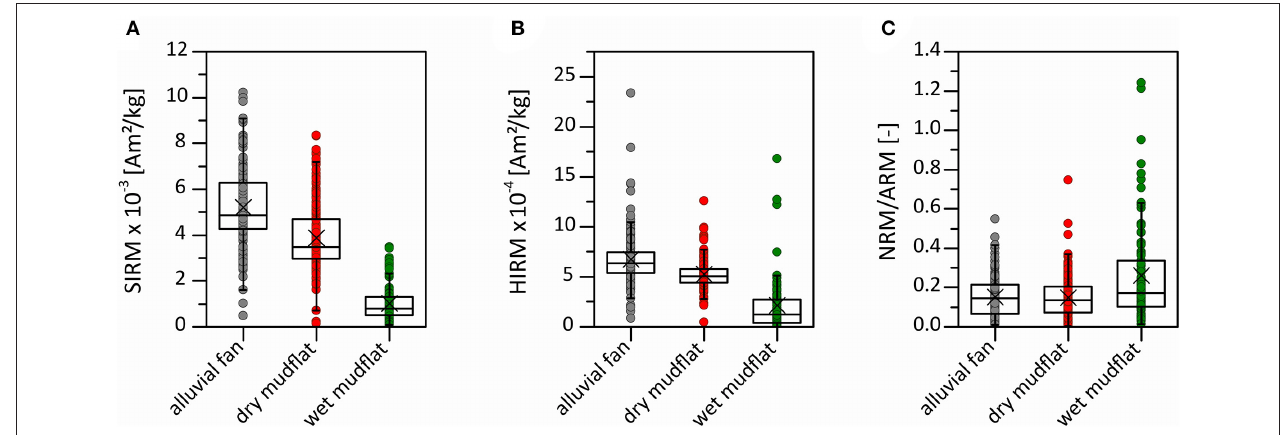
FIGURE 9 | Lithofacies and rock magnetic characteristics: box plots of the concentration-dependent parameters (A) SIRM, (B) HIRM, and (C) NRM/ARM ratio with means indicated by crosses, quartiles boxes and whiskers with a factor of 1.5. All consistently indicate statistically different mean values for the wet mudflat facies, supporting alteration of the primacy magnetic mineralogy in this